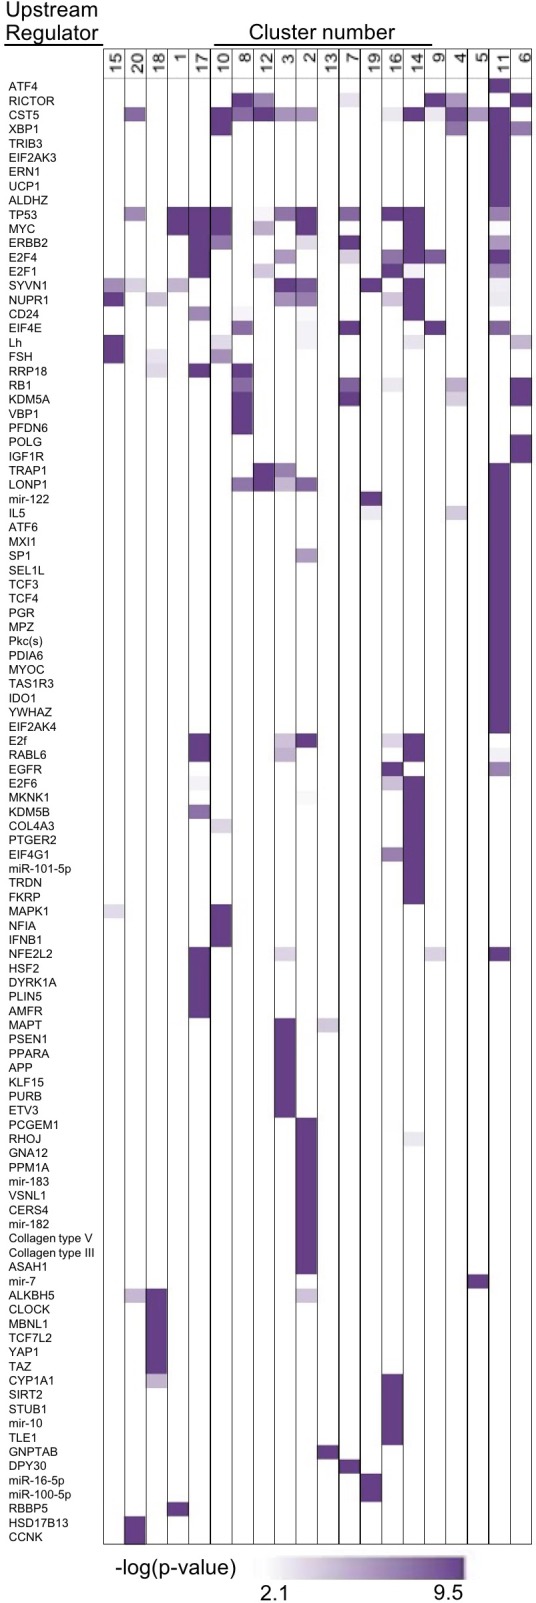
ATF4 and other upstream regulators target specific groups of genes.We used IPA to screen for significantly enriched (p-value<0.001, purple) upstream regulators in each respective cluster, based on prior knowledge of transcriptional regulators and their targets. Indeed, ATF4 and other stress-related transcription factors are strongly enriched in the UPR cluster (cluster 11, Figure 3C).